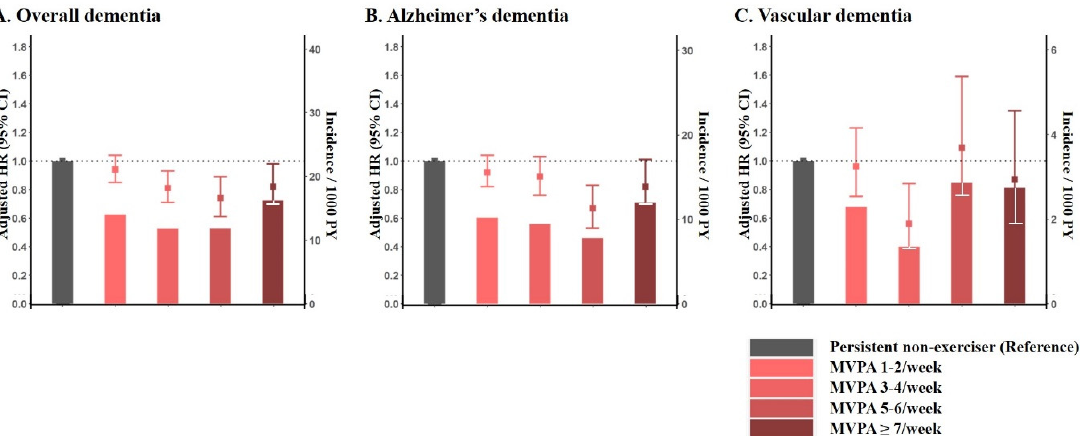
Figure 3. Risk of incident dementia stratified by dose of physical activity among exercise starters. Incidence/1000 person- years and adjusted hazard ratio for overall dementia ( A ), Alzheimer’s dementia ( B ), and vascular dementia ( C ) are presented in bars and error-bars, respectively. MVPA: Moderate to vigorous physical activity.